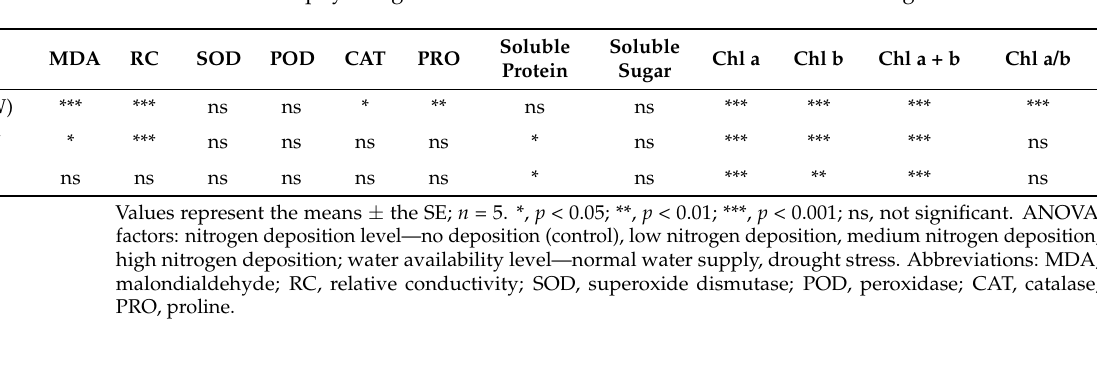
Table 2. ANOVA results of the effects of water supply and nitrogen deposition levels and their interactions on the physiological characteristics of Bretschneidera sinensis